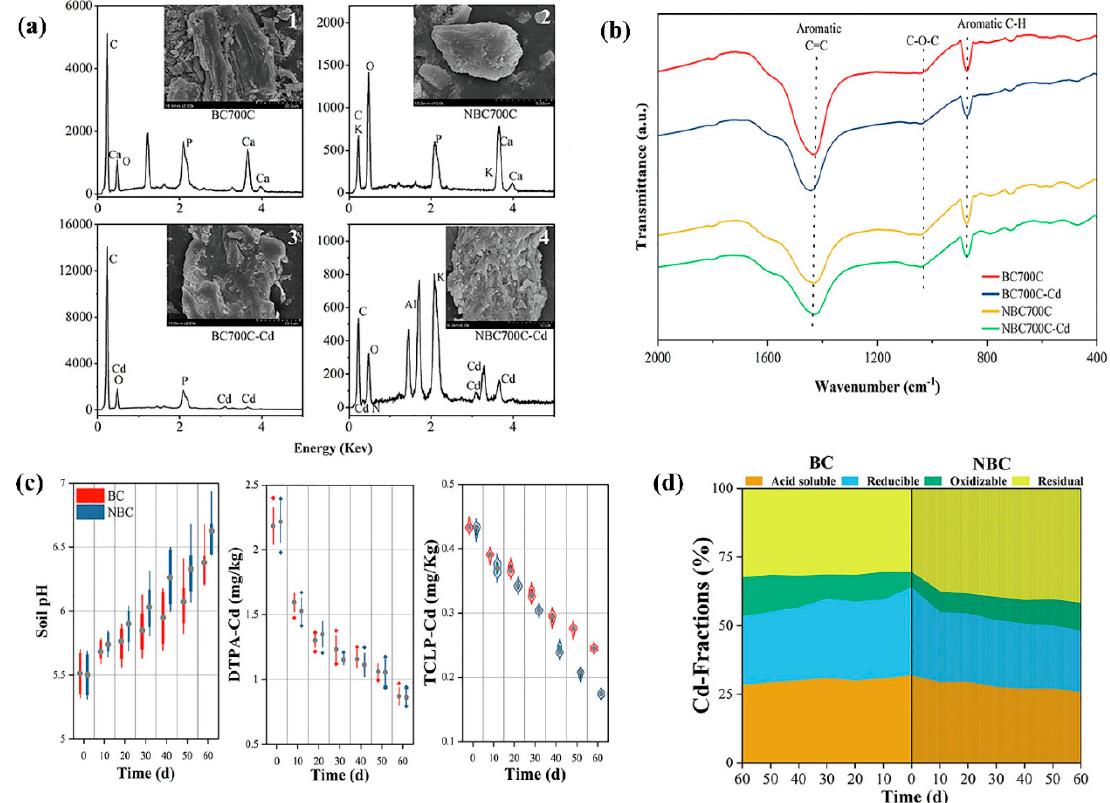
Figure 4. ( a ) Characterization of BC700 and NBC700 before and after Cd(II) adsorption, ( b ) FTIR spectra, ( c ) Cd(II) remediation application potential test. Soil pH, DTPA-Cd concentration, and TCLP-Cd solubility over time, ( d ) soil Cd(II) morphological classification over time [108] (Repro- duced with permission from Liu et al., Separation and Purification Technology, published by Else- vier, 2022).